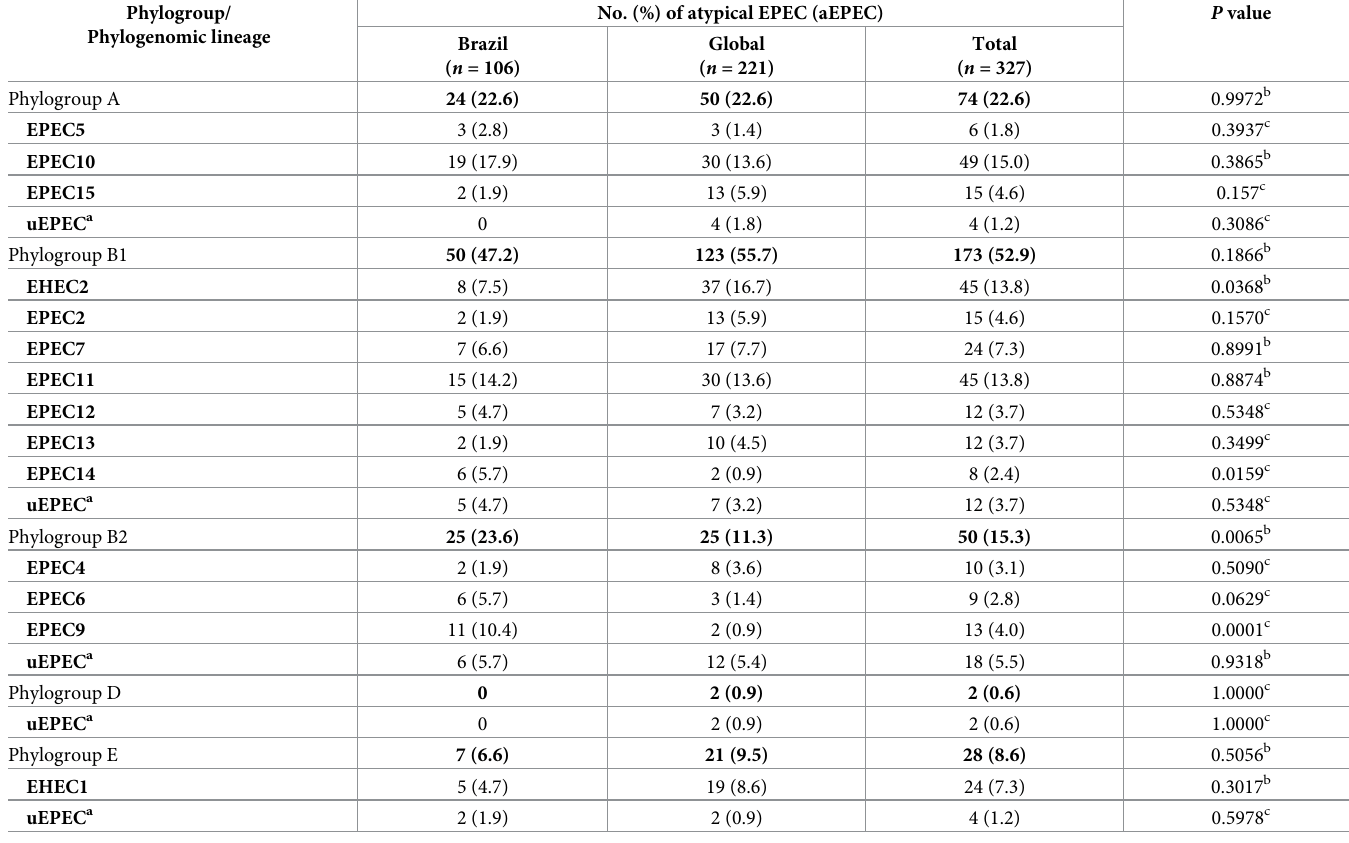
No. (%) of atypical EPEC